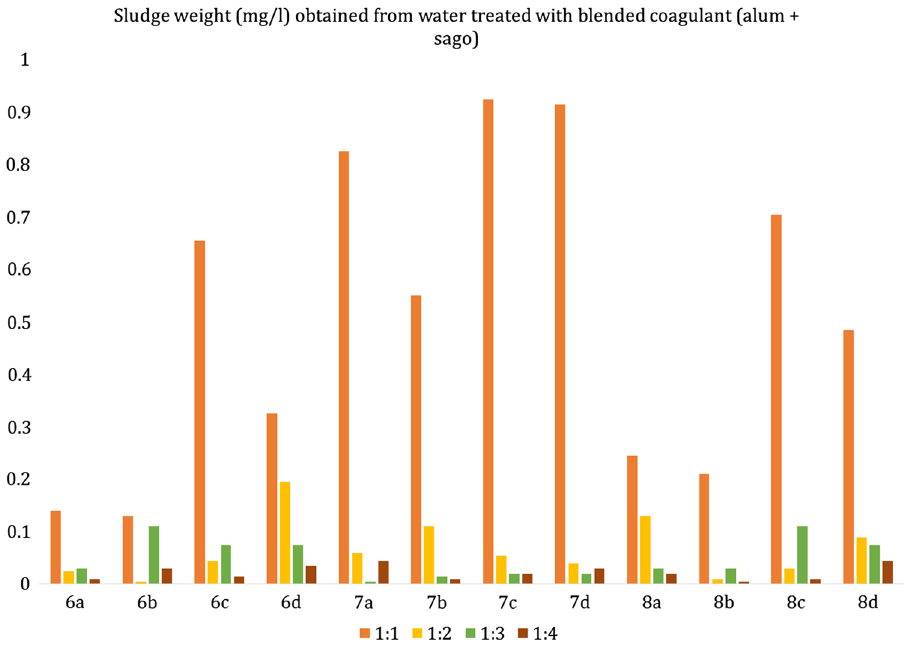
in various physicochemical parameters of surface water after treatment with blended coagulant (alum + chitin + sago—1:1 ratio)